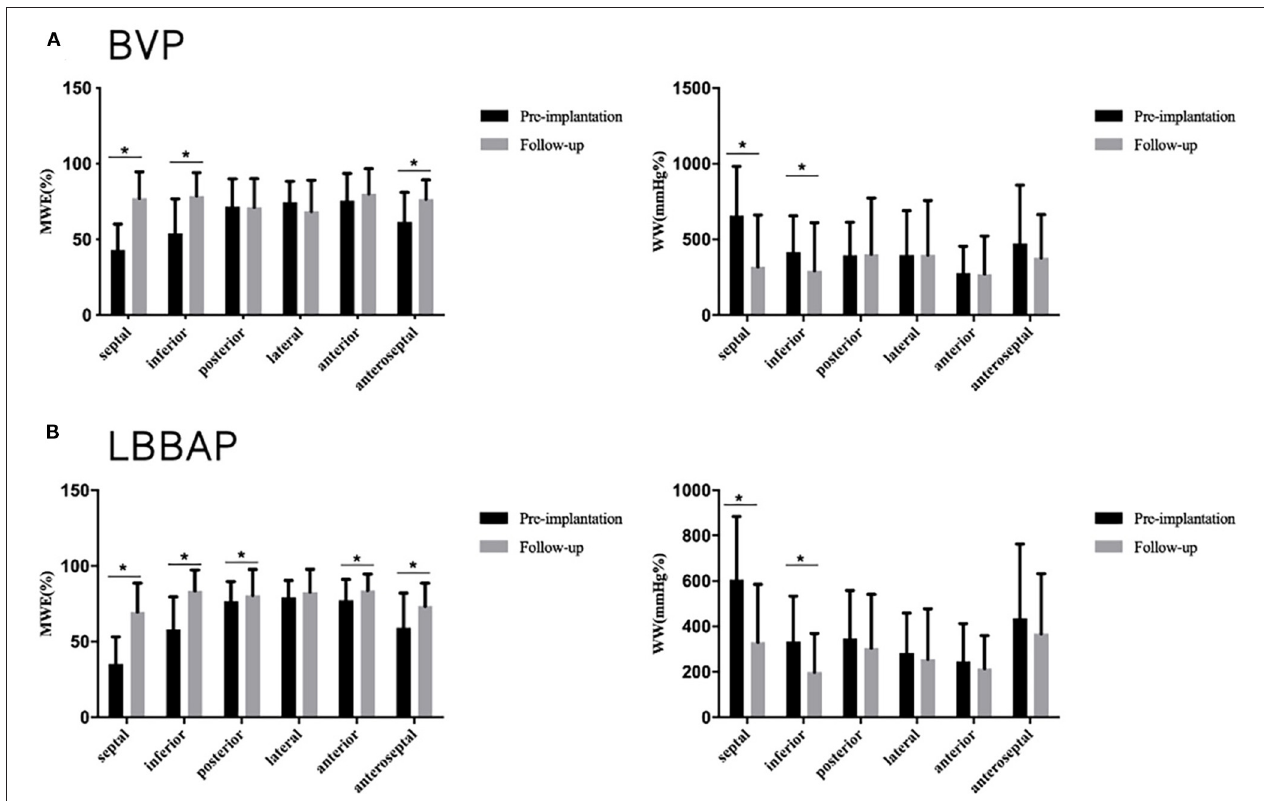
FIGURE 4 | Segmental myocardial work at baseline and follow-up in the BVP and LBBAP groups. (A) Segmental myocardial work (MWE) and segmental wasted work (WW) at baseline and follow-up in the BVP group; (B) Segmental myocardial work (MWE) and segmental wasted work (WW) at baseline and follow-up in the LBBAP group. * p <